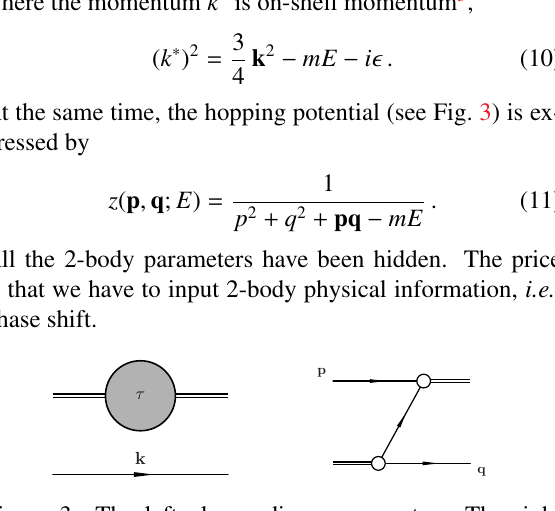
Figure 3: The left plane: dimer-propagator. The right plane: hopping